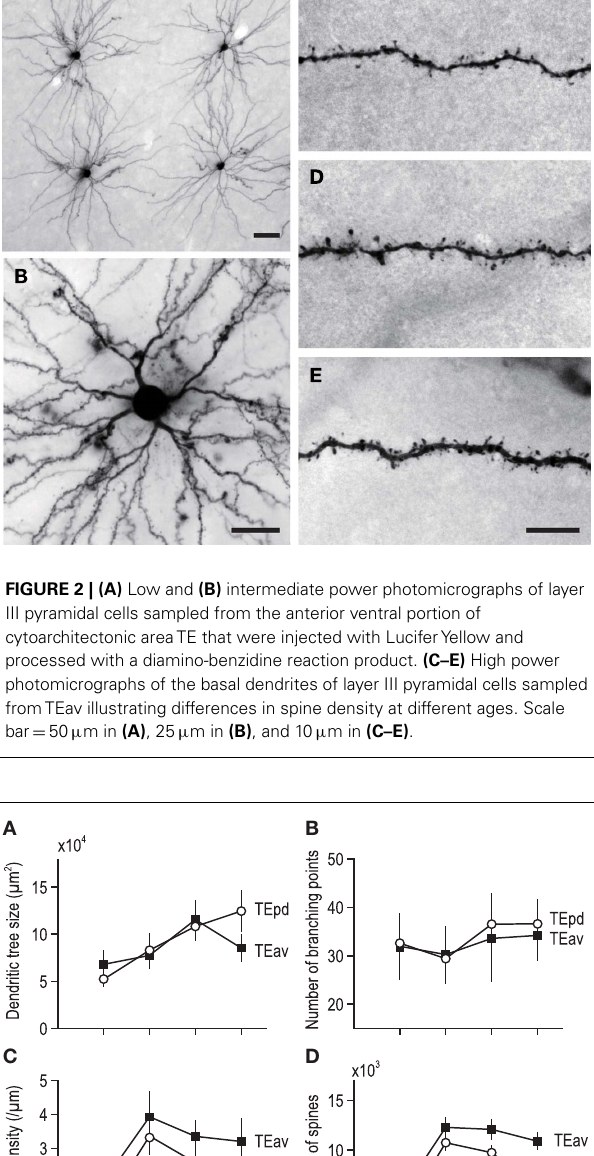
basal dendritic trees of pyramidal cells across the age groups ( F (3) =